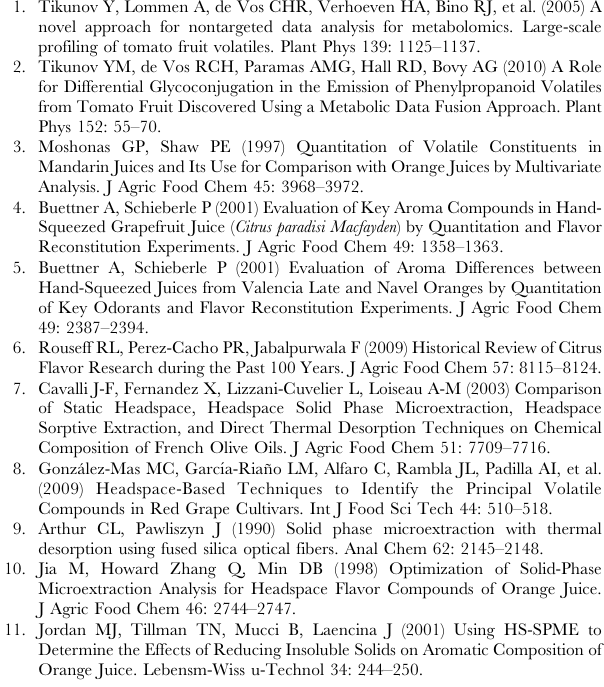
Figure S1 Principal Component Analysis score plot (t[1] vs t[3]) for the first and third principal components. (TIF) Figure S2 Principal Component Analysis loading plot (p[1] vs p[3]) for the first and third principal compo- nents. Each number corresponds to a particular volatile compound, as indicated in Table 1. (TIF) Figure S3 Chromatograms representing each of the varieties analyzed: A, Chandler; B, Clemenules; C, Fortune; D, Powell. (TIF) Table S1 Pearson correlation coefficients for each of the volatile compounds. Significant correlations (p , 0.01) are highlighted in bold. (XLS) Table S2 Volatile organic compounds injected as stan- dard but not identified in any juice analyzed.